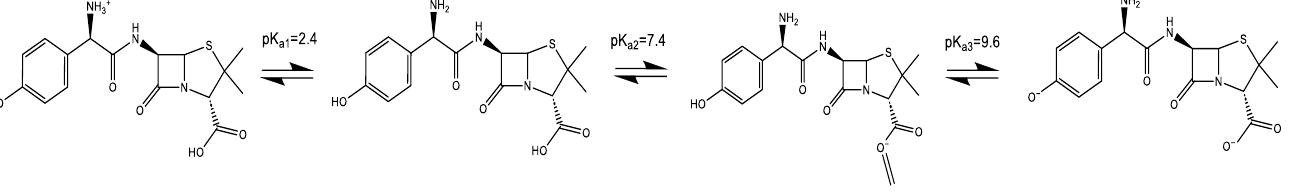
Figure 8. Amoxicillin (AMX) Ionized forms with different pKa values.